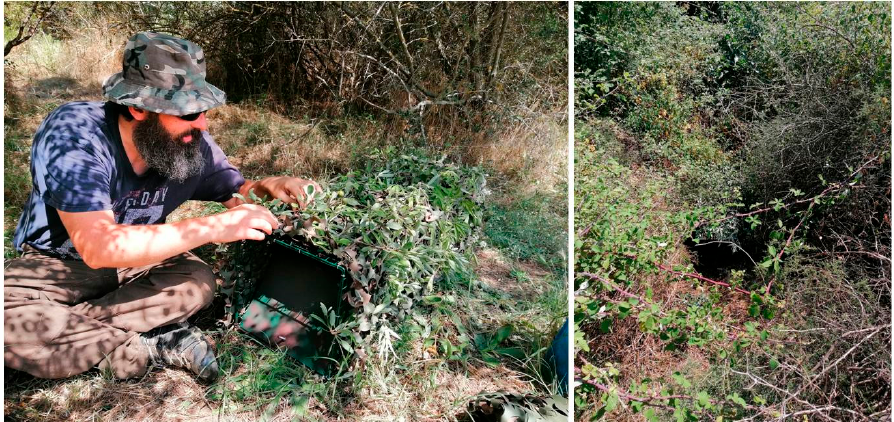
Figure 3. Preparation and placement of the cage traps used.